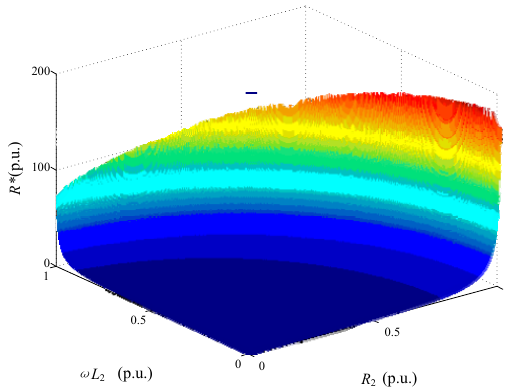
Figure 4. The relationship between R * and ZH (p.u.).